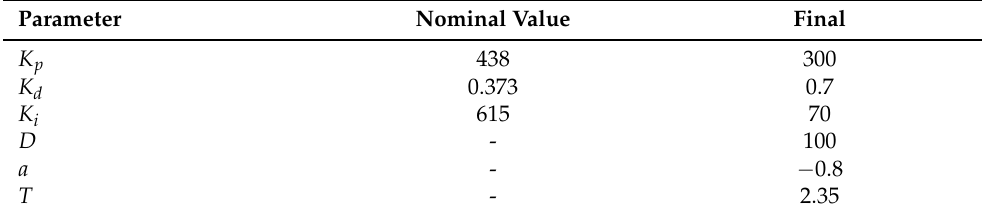
Table 2. Control parameters (5) and (6).